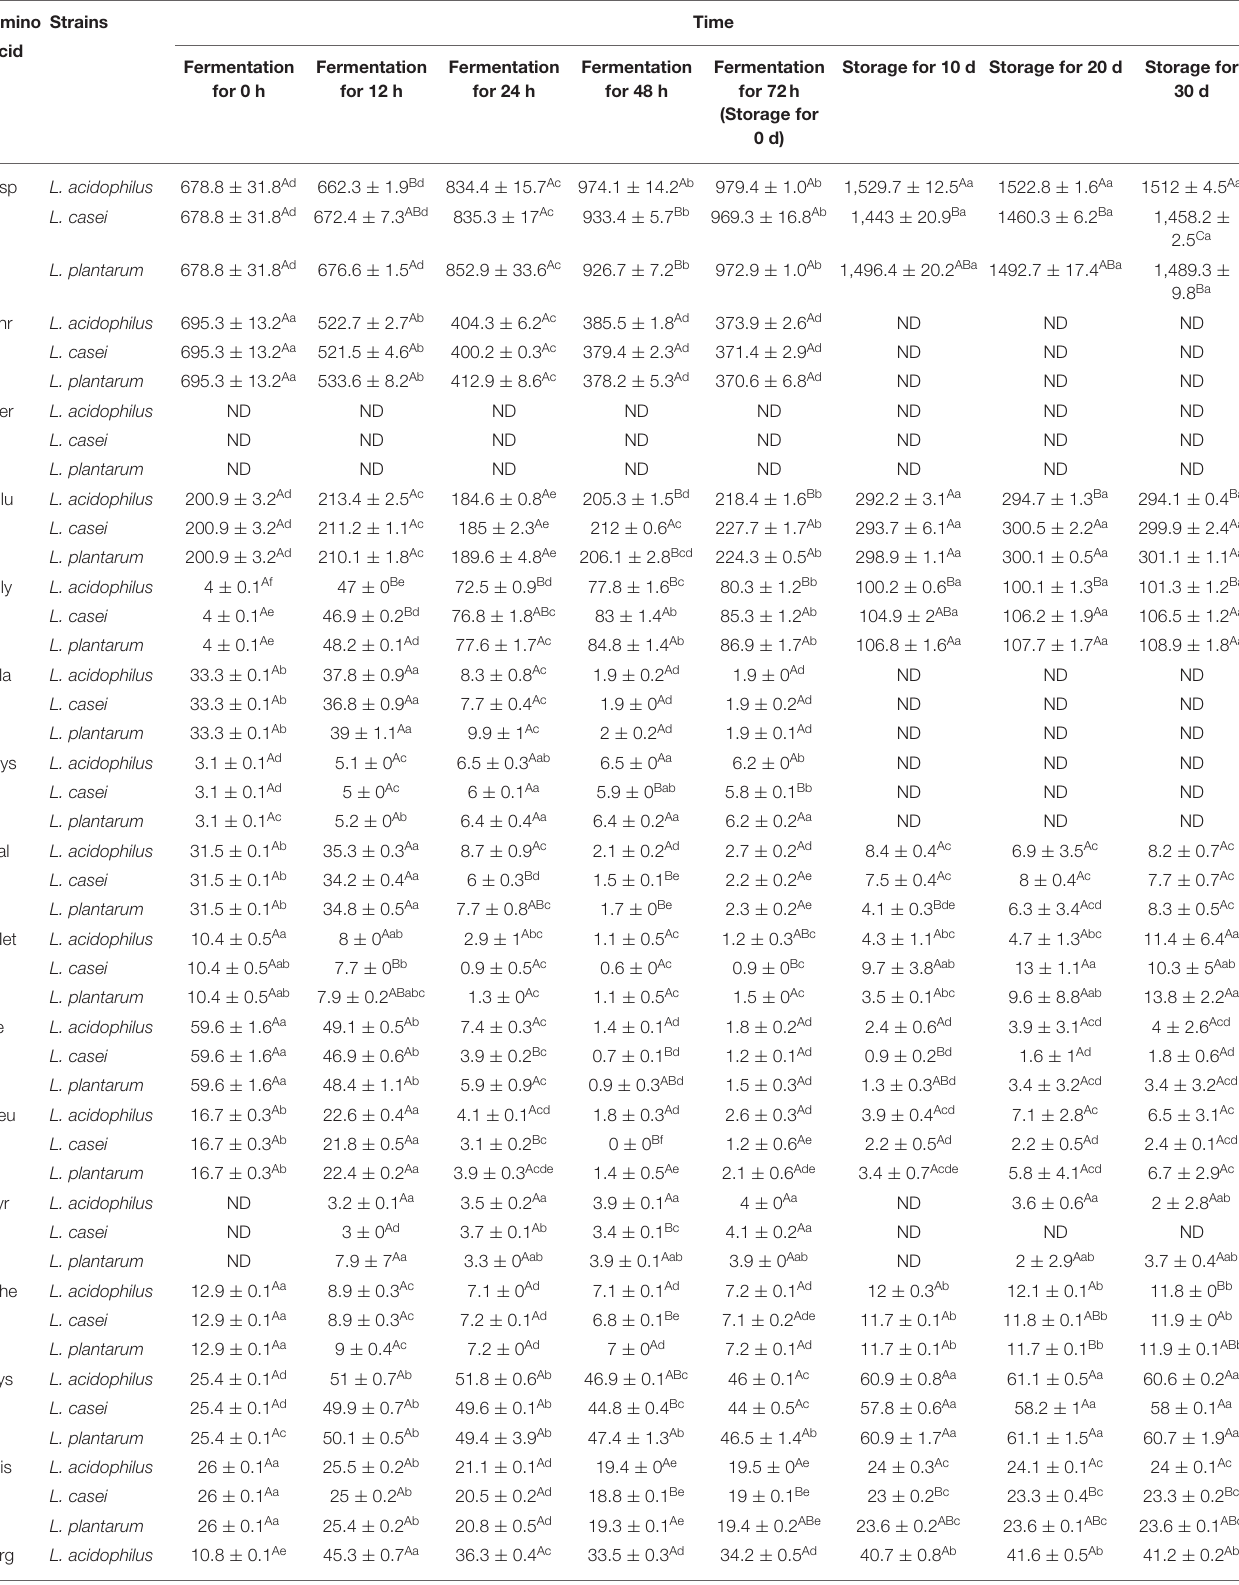
TABLE 1 | Changes in the contents of free amino acids (mg/L) of apple juice during lactic acid fermentation and the subsequent refrigerated storage period (4 ◦ C, 30 days). Amino Strains Time